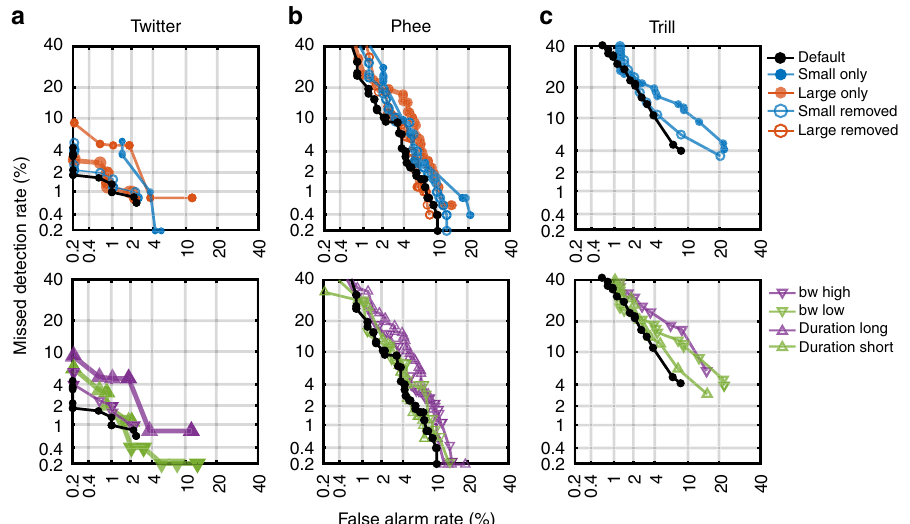
Fig. 7 The precedence of intermediate features for classi fi cation. DET curves for call classi fi cation using features of different sizes, bandwidths, and durations for the classi fi cation of a twitters, b phees, and c trills. The default model is in black. Top row shows performance when using small features only (<100 ms and <1 oct; blue discs.) or excluding small features (blue circles), and using large features only (>250 ms and >2 oct.; red discs) or excluding large features (red circles). For trills, some of these conditions fall outside the range of the axes. Bottom row shows performance when feature bandwidths and durations were independently varied. Because of the short duration of trill calls, we did not test the effect of using only long duration features. Symbols are: purple inverted triangles — high bandwidth features only, green inverted triangle — low bandwidth features only, purple triangle — long-duration features only, green triangle — short-duration features with the number of sweeps present in the train (darker colors correspond to more sweeps). Three of the top 5 twitter MIF-